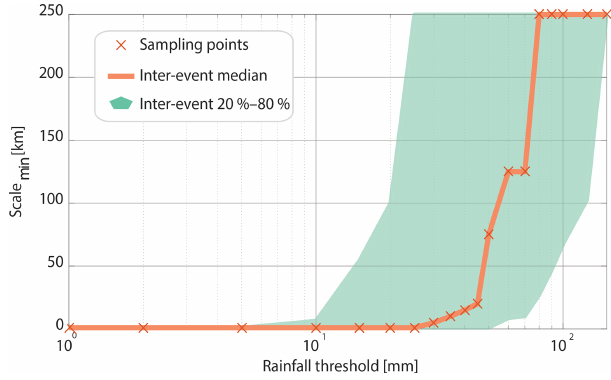
Figure 9. Minimal scale (see Fig. 7f and Sect. S1 in the Supple- ment) derived for all 41 events for various rainfall thresholds.